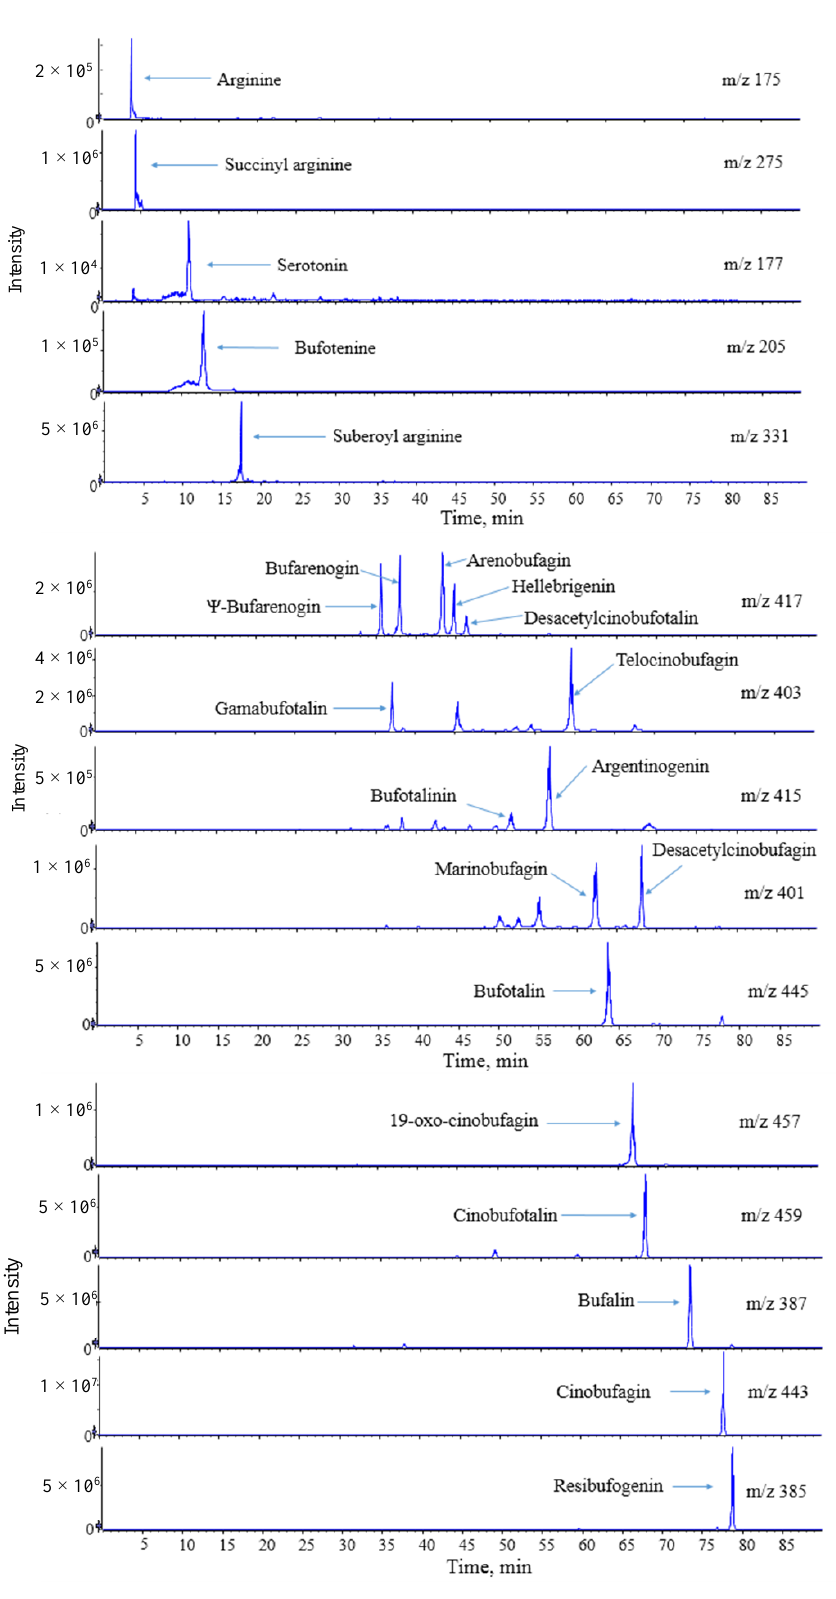
Figure 2. The extracted ion chromatograms (XICs) of the main compounds in the positive ion mode.